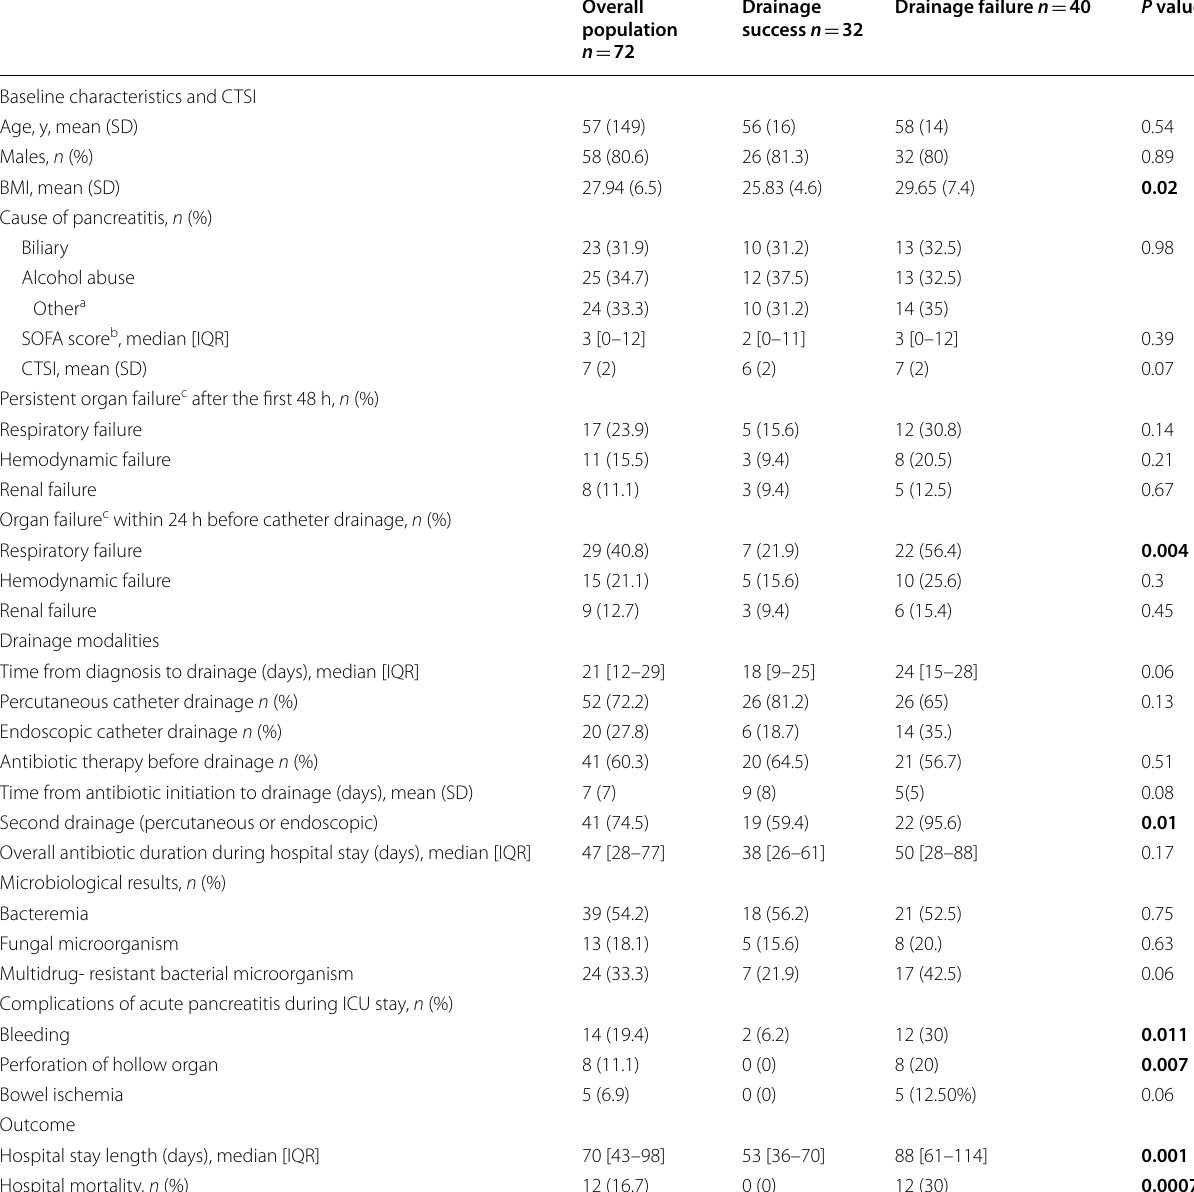
Table 1 Baseline characteristics and outcomes of the study